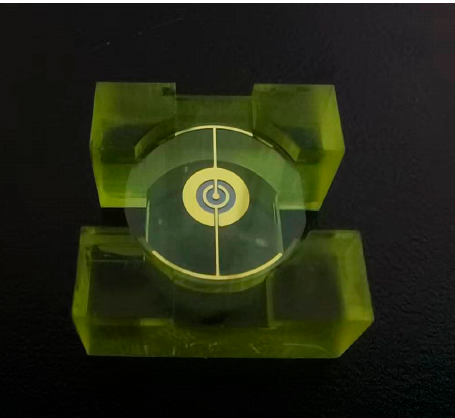
Figure 9. Photograph of the fabricated the QCM with double-finger electrode.